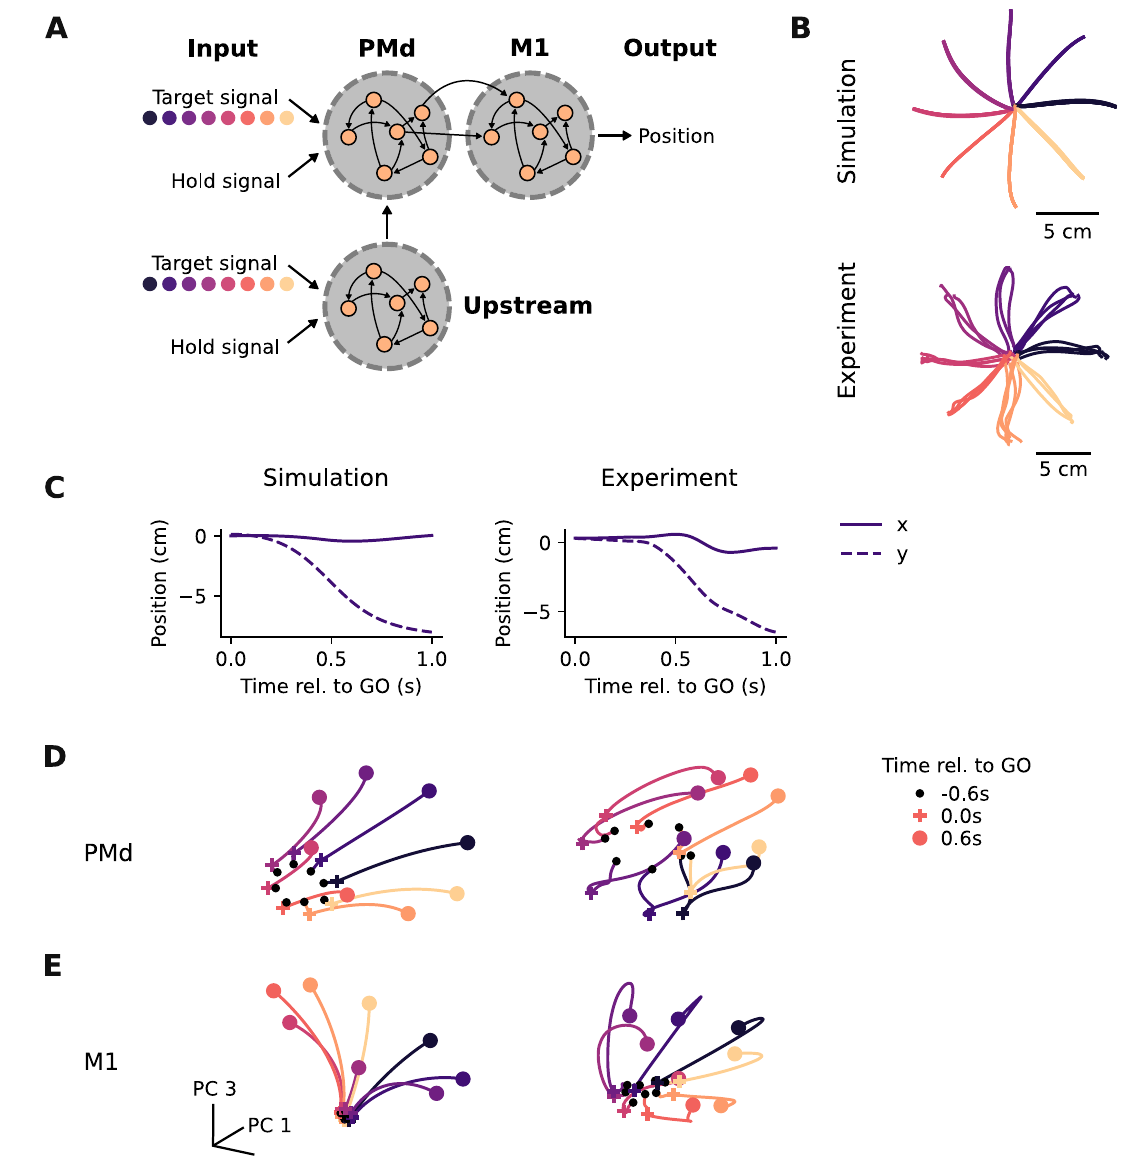
Fig.3|AmodularrecurrentneuralnetworkmodeltostudyVRadaptation.A A modular RNN that models key motor cortical areas to study adaptation. B Simulated (top) and actual(bottom) hand trajectoriesduring 30reaches to each target taken from one session from Monkey C. C Example simulated and actual handtrajectoriestoonetarget.Notethesimilarityinkinematicsbetweenthemodel